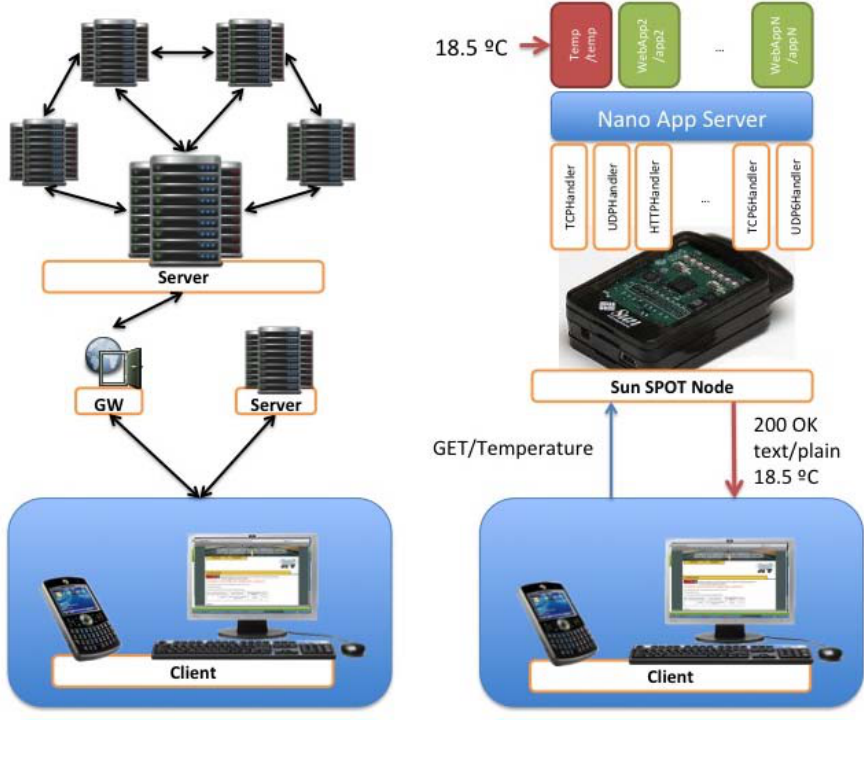
Figure 10. Comparison example between Web Architecture ( left ) and its mapping to a REST Architecture ( right